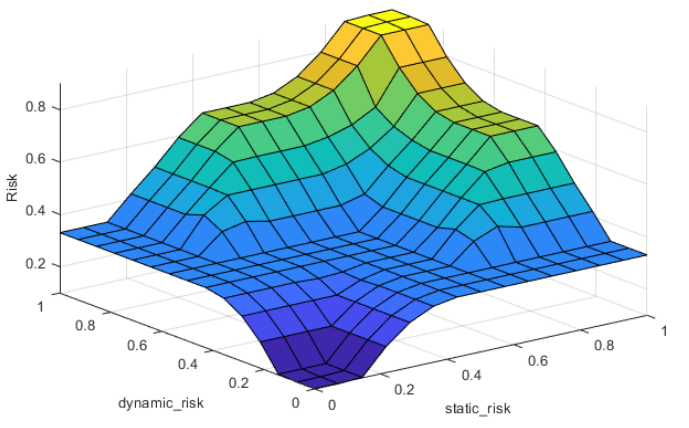
Figure 10. Surface plot of the FIS based on the expert rule base, showing dependency of the individual risk on the dynamic and static risk